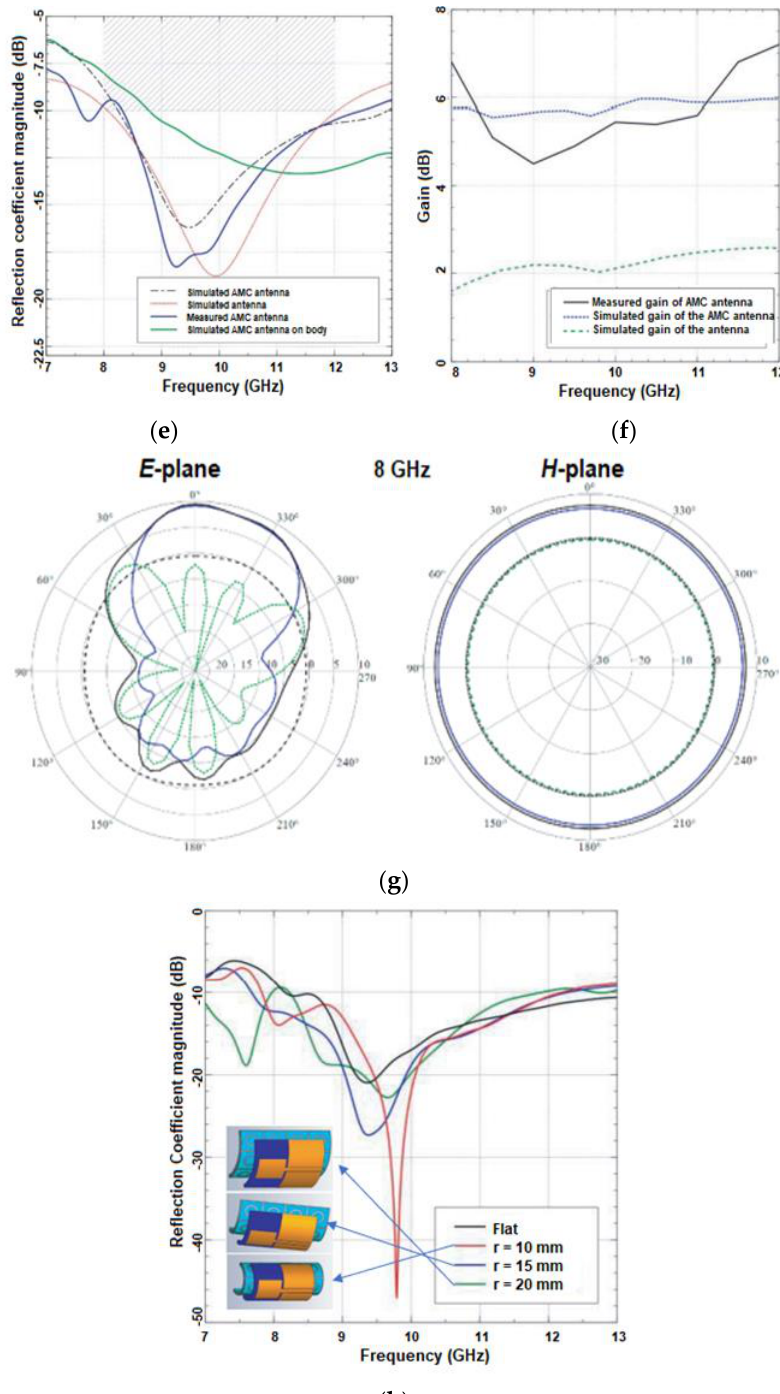
Figure 11. ( a ) Fabricated UWB antenna. ( b ) S11 of the monopole antenna. ( c ) Gain of the monopole antenna. ( d ) The geometry of the AMC antenna. ( e ) S11 of the AMC antenna. ( f ) Gain of AMC antenna. ( g ) Radiation patterns. ( h ) S11 of the antenna on bending. Reprinted ( a – h ) from Ref. [29].